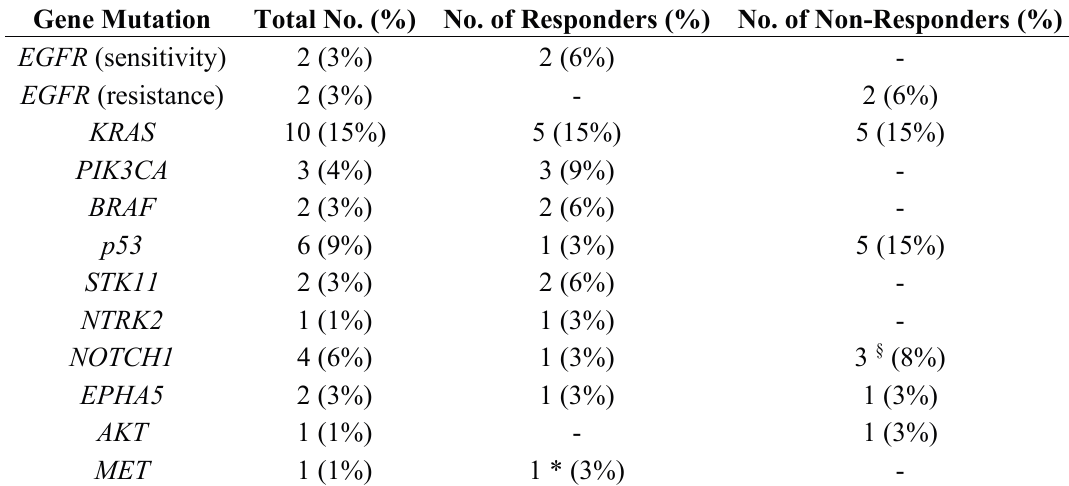
Table 2. Gene mutations identified using LungCarta